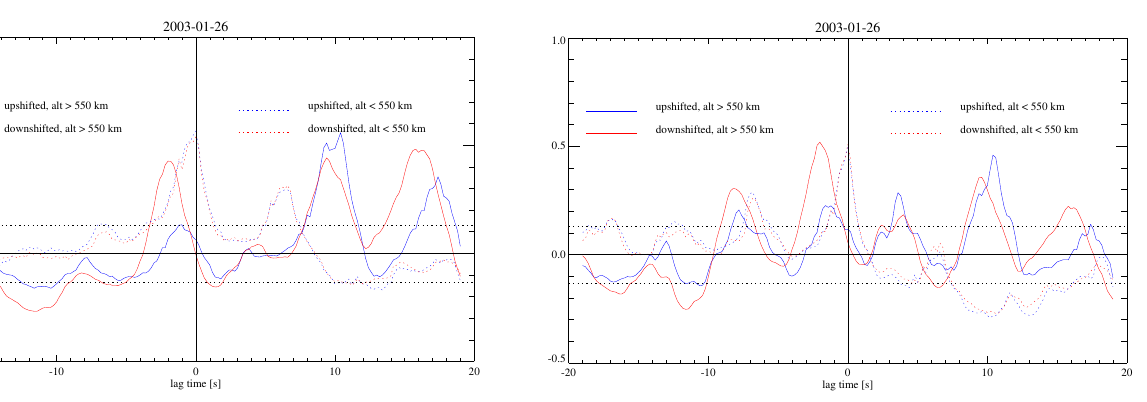
Fig. 7. Same type of correlation as in Fig. 6, from the same time, but the in-beam luminosity is taken from the SIF imager mounted at the Auroral